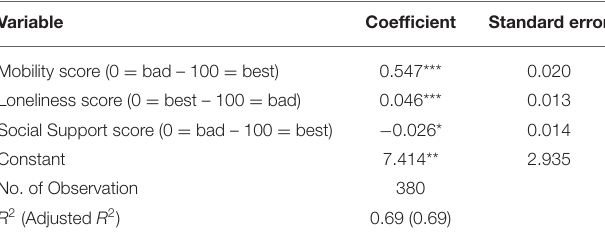
TABLE 4 | Final regression model considering functioning and disability as dependent variable, measured through the WHODAS 2.0 instrument, adjusted for age and